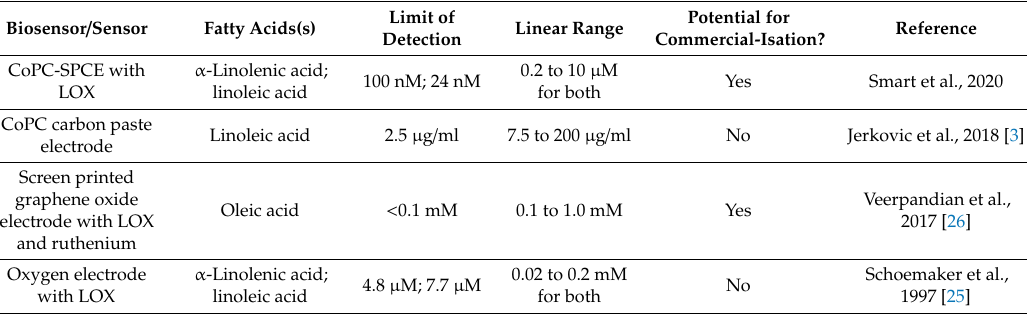
Table 3. Electrochemical approaches for measuring unsaturated fatty